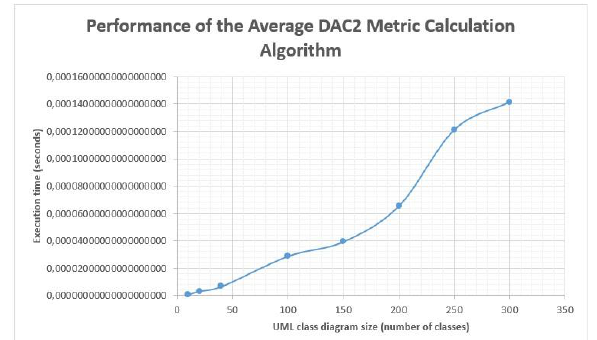
Fig. 10. Performance of the Average DAC2 Metric Calculation Algorithm